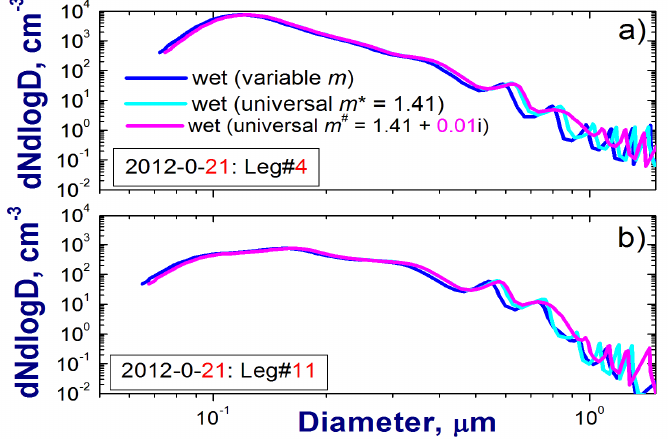
Figure 11. Example of size distributions obtained for two FLs (21 July 2012) and different values of RI. Measured dry size distributions are converted into their wet counterparts with the size-dependent scaling factor calculated for universal (cyan, magenta) and variable (blue) RI. Two values of universal RI are assumed: m * = 1.41 (cyan) for a non-absorbing aerosol and m # = 1.41 + 0.01i (magenta) for an absorbing